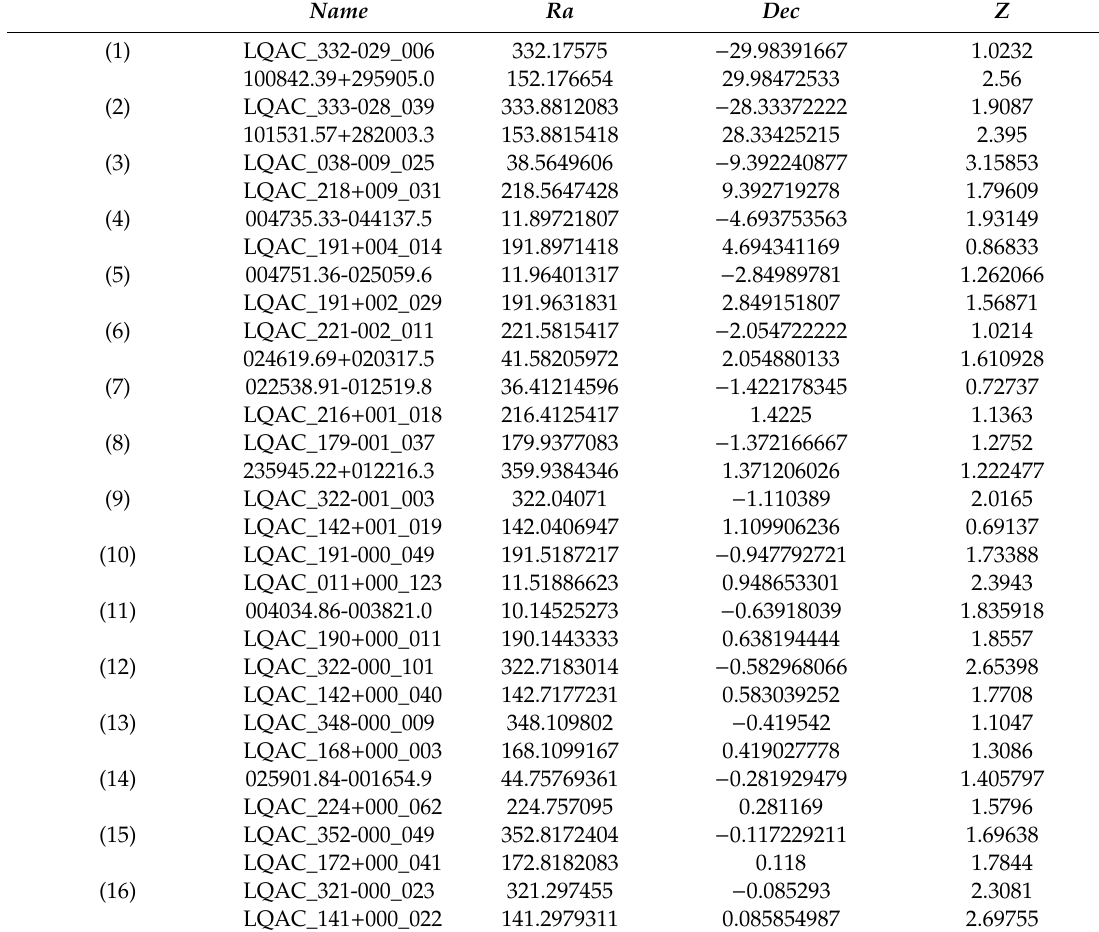
Table A20. Pairs of opposite quasars from the KQCG catalog [48] as candidates for the cosmic mirror e ff ect—alternative approach. Accuracy is of 0.001 ◦ for ra and dec and z / 2 for z